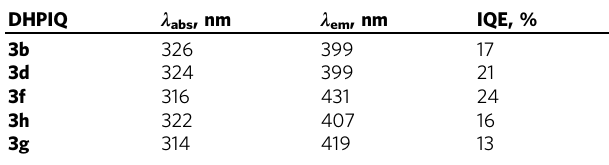
The IQE was measured using an integrating sphere upon sample excitation with